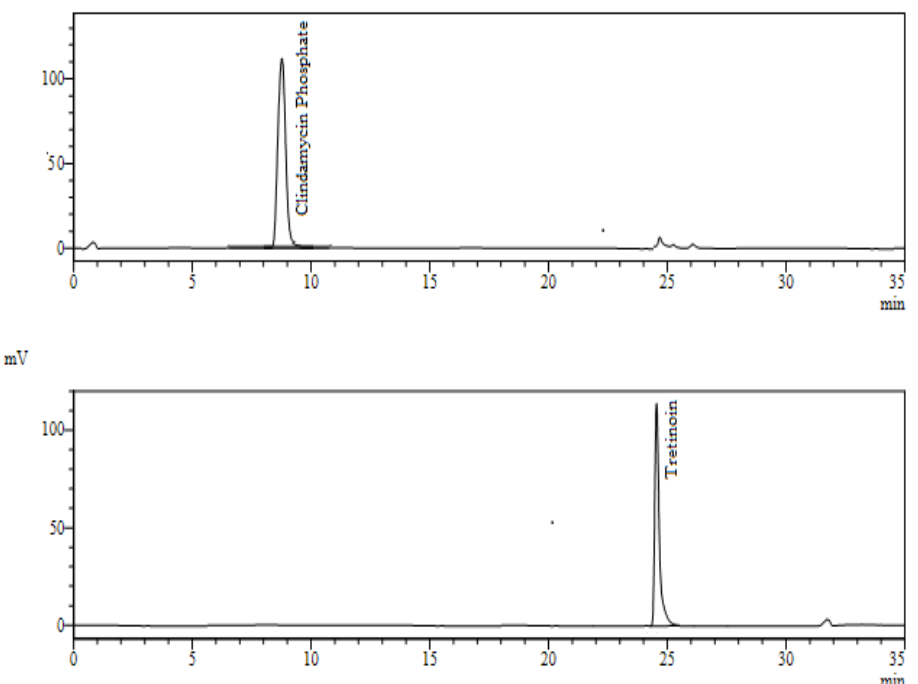
Figure 8. HPLC chromatogram of Clinda-T Gel analysis. Peaks: clindamycin phosphate, t R ∼ 8.9 min; tretinoin, t R ∼ 24.8 min.